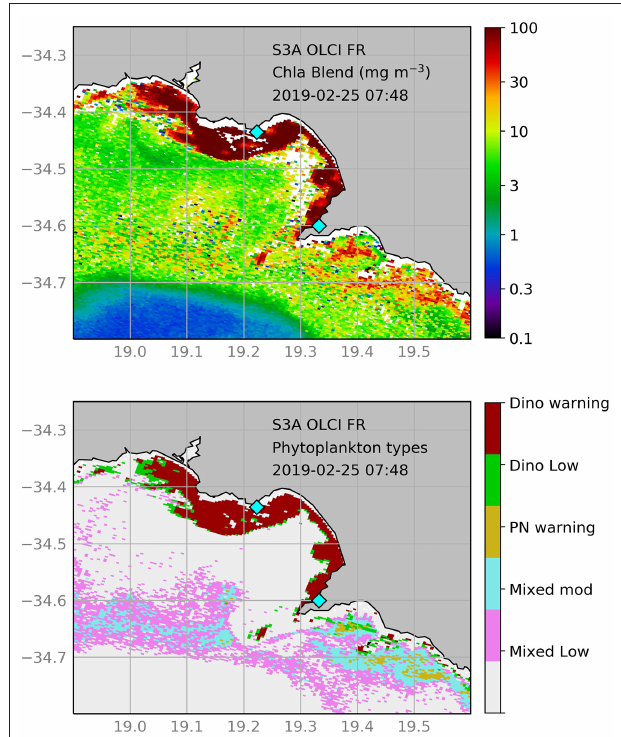
FIGURE 6 | Satellite products derived from full resolution S3A-OLCI for the 25th of February 2019. The top panel shows [Chl-a], whilst the bottom panel shows the probabilistic phytoplankton community classification (PPCC); classes include dinoflagellate (red) and Pseudo-nitzschia (yellow) dominated waters, as well as high (green) and moderate (blue) biomass mixed assemblages. Please refer to Table 2 for a detailed PPCC color key. The locations of two of the primary water intake pipes for abalone farms in the area are indicated by blue